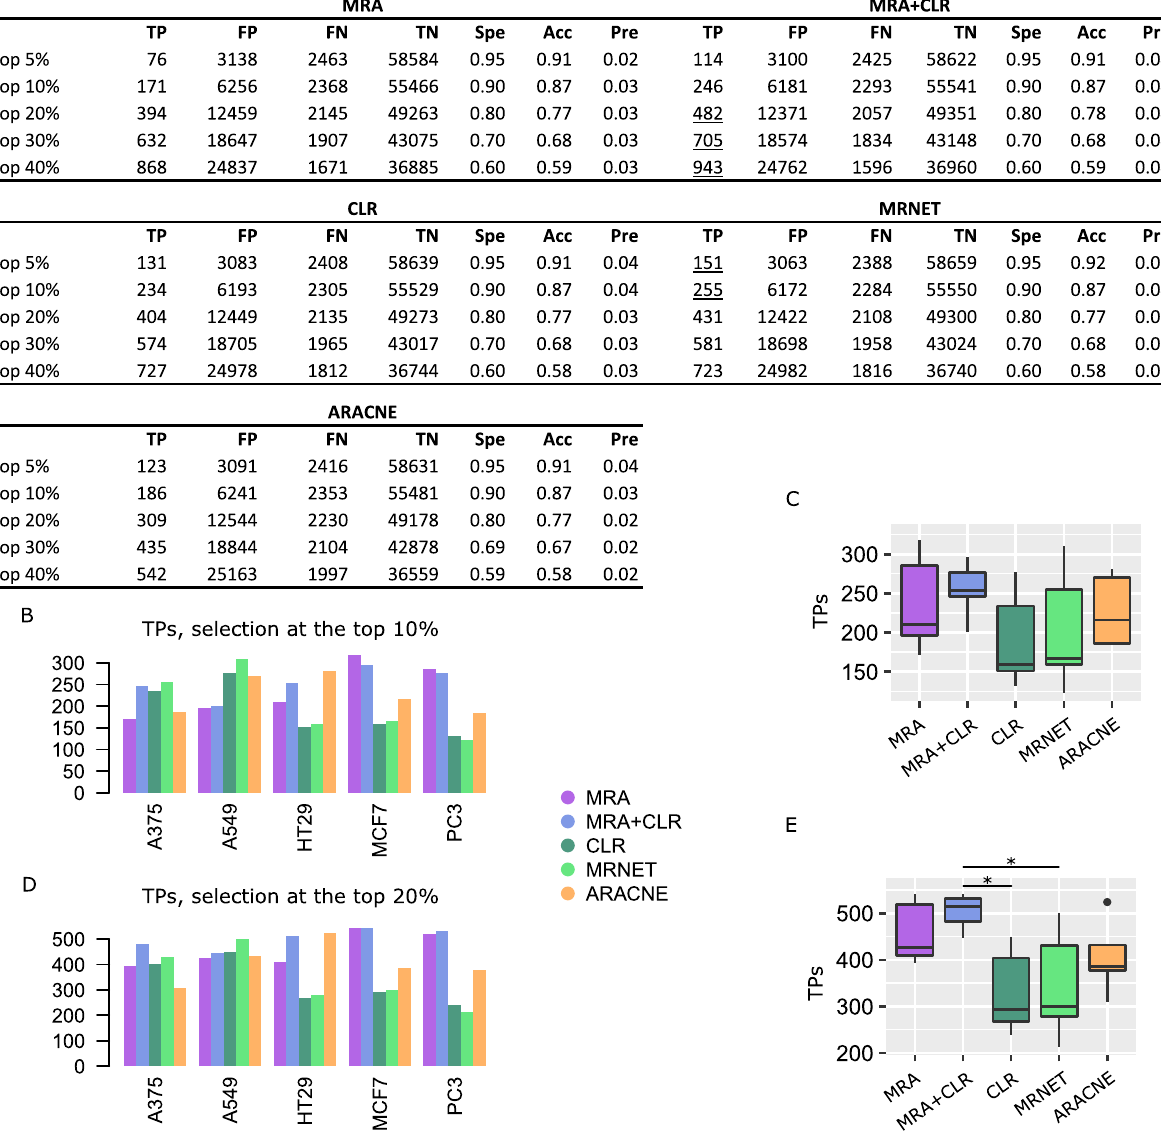
Fig 6. Performance on L1000 CRISPR/Cas9 data against STRING interactions (STRING score > 0.5). (A) Representative confusion matrices for A375 cells. (B) TP numbers at the top 10% selection level. (C) Comparison between the algorithm TP numbers. (D) TP numbers at the top 20% selection level. (E) Comparison between the algorithm TP numbers (Wilcoxon test, 2-sided, � P < 0.05).